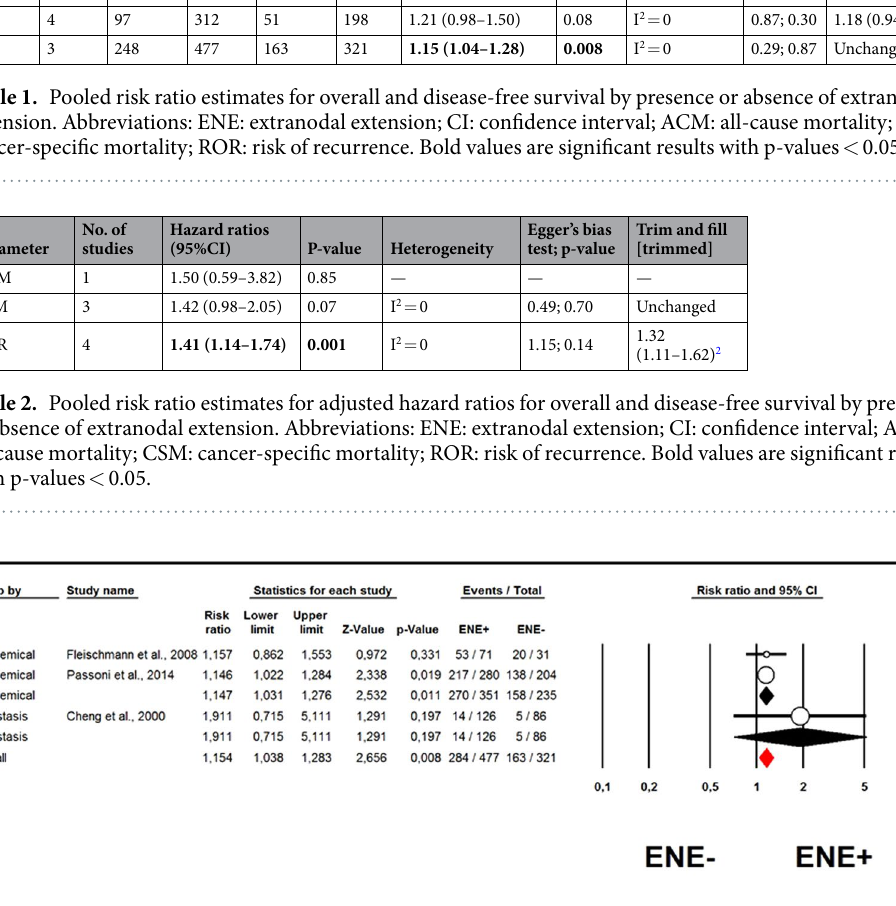
Figure 2. Forrest plot for relative risk of recurrence by extranodal extension status. First of all we present the data about risk of biochemical recurrence (papers of Fleischmann et al ., and of Passoni et al .), then their meta- analyzed values (pooling data), then the data about risk of metastasis (Cheng et al .), its mean (only this study about the risk of metastasis, so we repeat this value), then the overall meta-analysis of these data (meta-analysis of all these papers about risk of recurrence – both biochemical and metastasis).